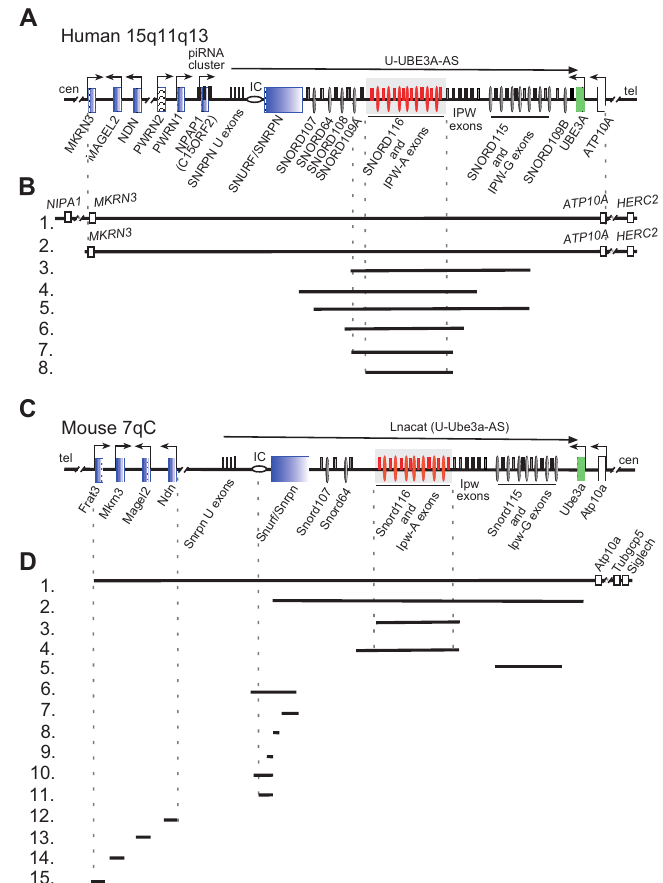
Figure 1. Organization of human and mouse PWS loci, deletions in human and PWS mouse models are indicated. ( A ) Schematic representation of the human PWS locus on chromosome 15q11-q13. Blue rectangles denote paternally imprinted protein coding genes. Thin ovals show snoRNA gene locations; the imprinting center (IC) is denoted by a horizontal oval. Thin rectangles above the midline depict non-protein coding exons. SNORD116 and IPW-A exons are displayed in red and further highlighted by a grey rectangle. Arrows indicate promoters and the direction of transcription. The long arrow on top shows the putative U-UBE3A antisense transcript harboring the SNORD116 and SNORD115 clusters. Centromere and telomere regions are indicated as cen and tel. ( B ) Schematic representation of PWS chromosomal deletions. Lines 1 and 2 indicate the common 5–6 Mb PWS deletion [2]. Lines 3 – 8 represent the characterized PWS cases with microdeletion in the Snord116 array. Line 3 .—[34], 4 .—[35], 5 .—[36], 6 .—[37], 7 .—[38], 8 .—[39] ( C ) Schematic representation of the mouse PWS-locus on chromosome 7qC (symbols as above). ( D ) Schematic representation of available mouse models in PWS research. ( 1 .) The largest chromosomal deletion that eliminates the PWS/AS region and a large portion of non-imprinted genes [40]. ( 2 .) Deletion of the mouse PWS-locus span from the Snurf / Snrpn to Ube3a genes [41]. ( 3 .) Deletion of the PWS critical region (~300 kb) ( PWScr ) comprising of Snord116 and IPW-A gene arrays [42]. ( 4 .) The Snord116del mouse model eliminating a larger ~350 kb PWScr genomic region [43]. Note, that the genomic assembly of PWScr is not completed, a gap of ~50 kb inside the Snord116 cluster might increase the snoRNA gene copy number and overall size of deletion (UCSC, GRCm39/mm39 chr7:59457067- 59507068). IC center (Details in Figure 2). ( 6. ) 35 kb deletion of IC center and Snurf/Snrpn exons 1–6